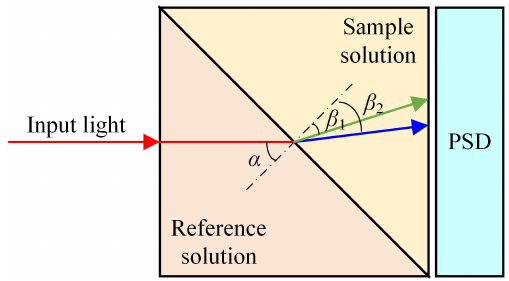
Figure 4. Principle of salinity measurement based on beam